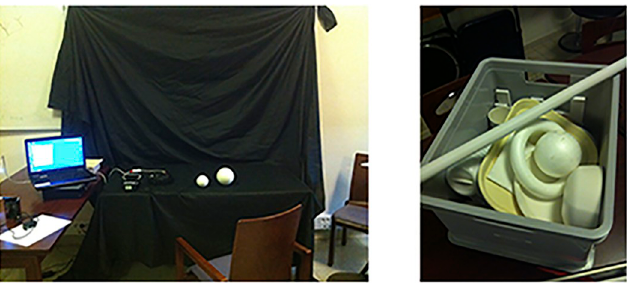
Fig 4. Pictures of a training context for the first exercises. Recurring shapes used during these exercises are: rectangles (or a sheet of white paper), circles (or a white ball), squares, half circles (or a banana), and later during what is called the “grating test,” an acuity measure that is performed regularly throughout the protocol, as it is used as a reference point and outcome measure. (photos by HK).